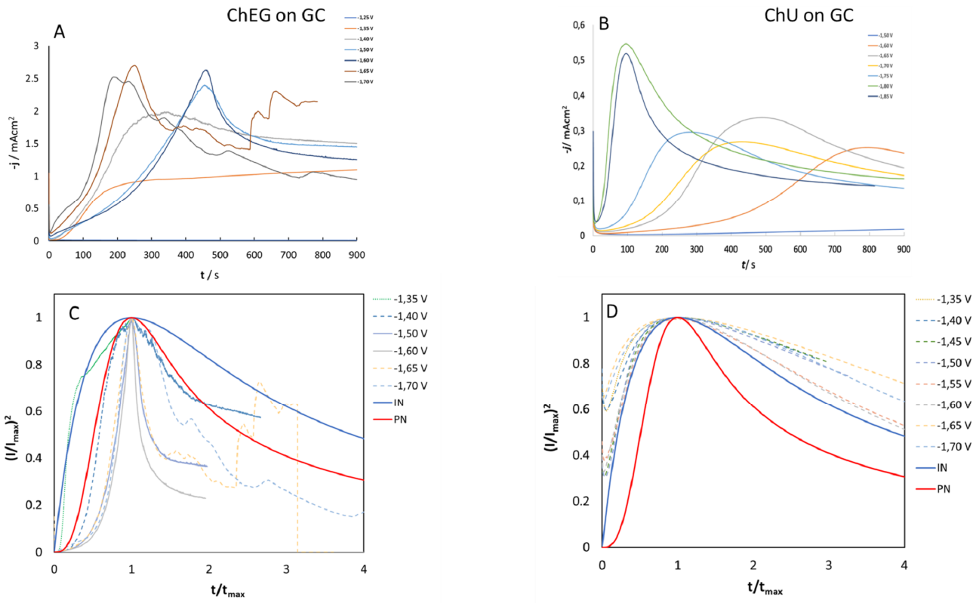
Figure 9. ( A , B ): Chronoamperograms for 0.3 M ZnSO 4 in ChEG ( A ) and ChU ( B ) using a GC electrode at 25 °C. ( C , D ): Normalized experimental curves of Panels ( A , B ), plotted together with theoretical curves for progressive (solid pink line) and instantaneous nucleation (solid black line) according to the model of [32,33].